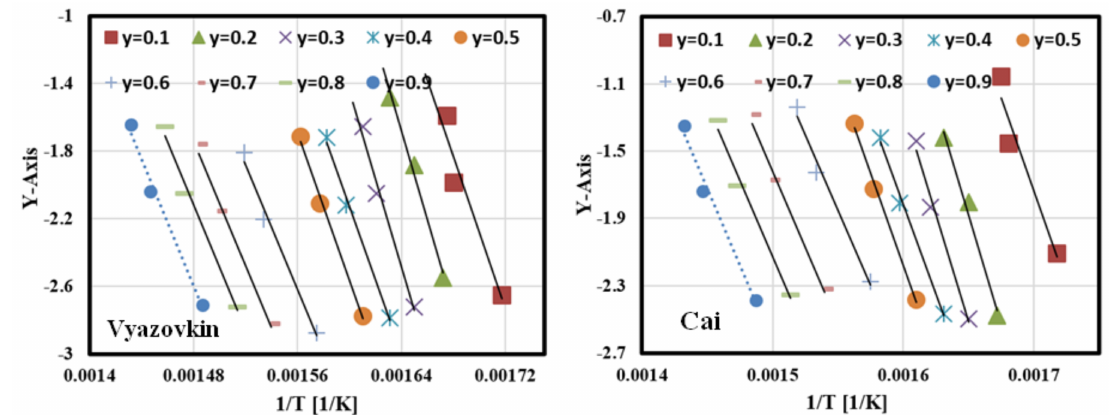
Figure 8. Plots of nonlinear isoconversional methods at different values of conversion.